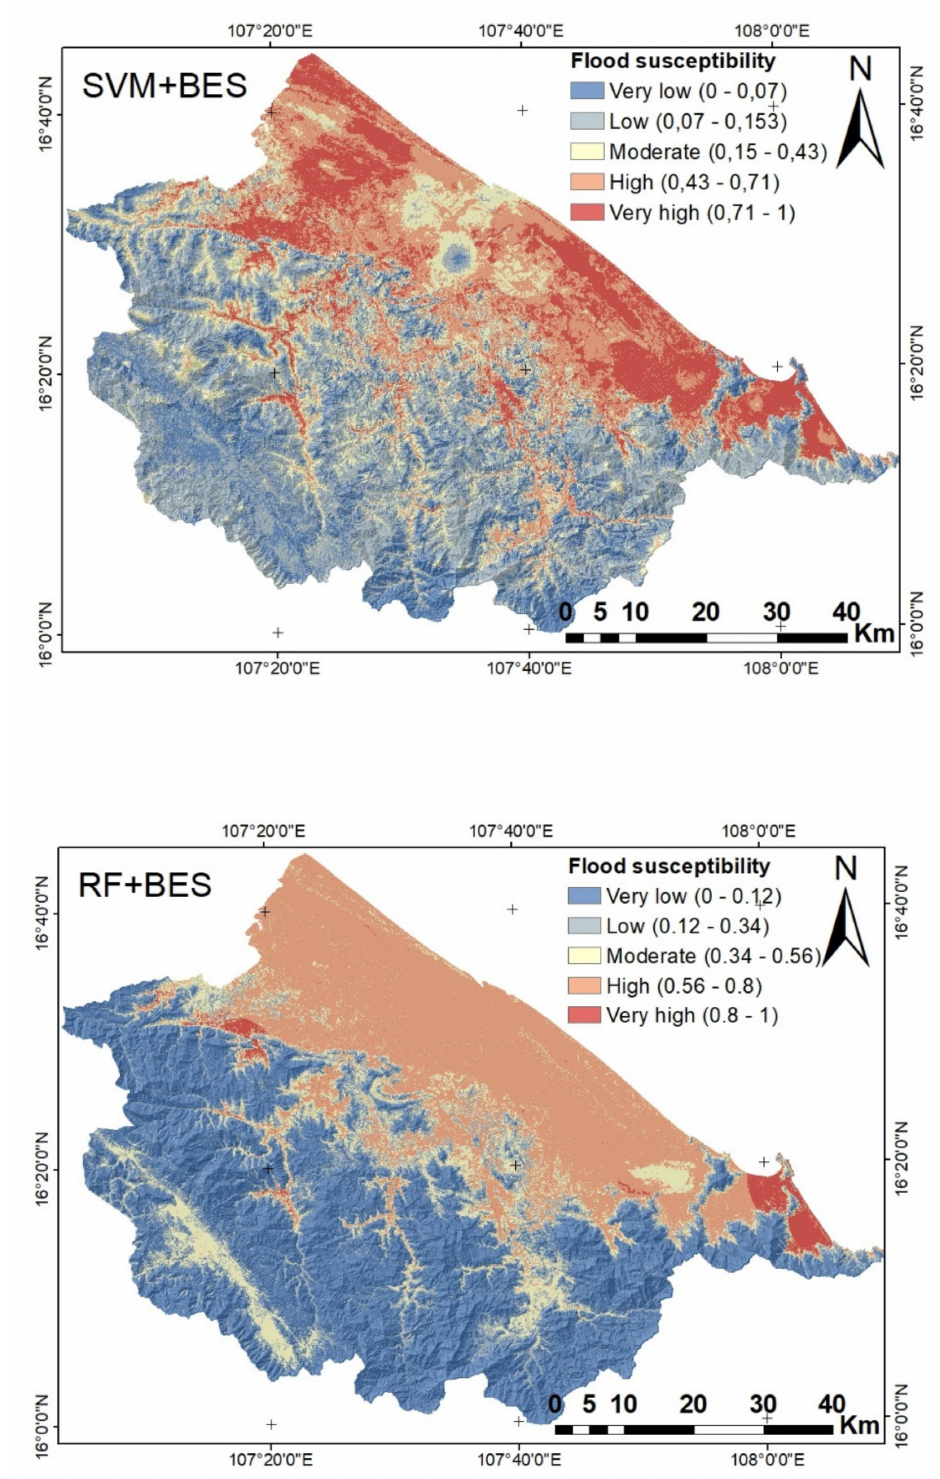
Figure 6. Flood susceptibility in the Hue